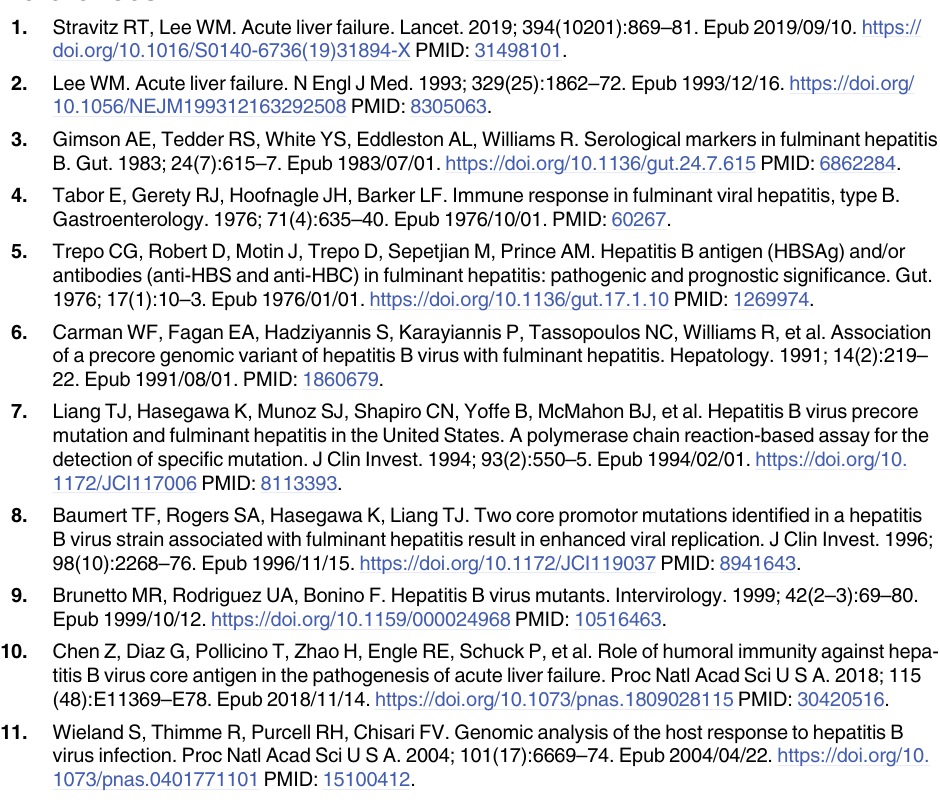
S1 Table. Expansion of anti-core antibody clones ( > 100 antibodies). All the anti-HBcAg antibody genes identified in the phage-display libraries were found in the corresponding liver antibody repertoire analyzed by next-generation sequencing, and in most cases were highly